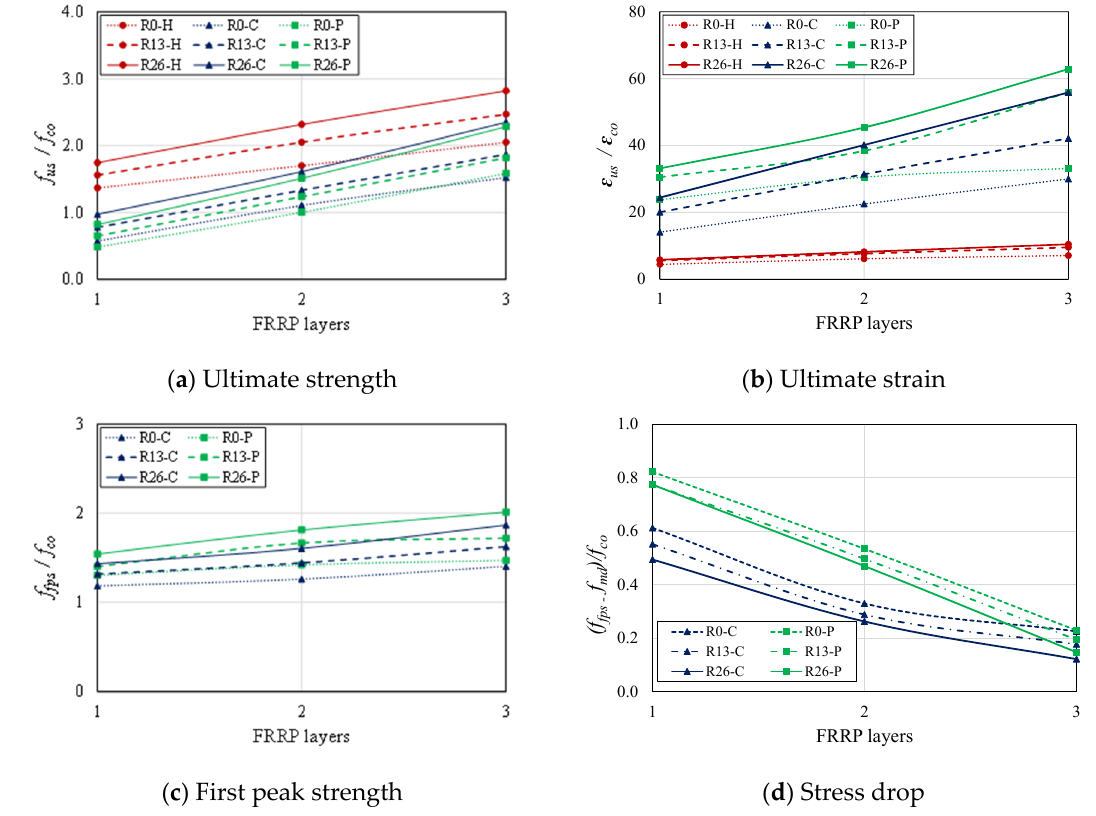
Figure 9. Effect of FRRP layers (R0 = 0 mm corner radius, R13 = 13 mm corner radius, R26 = 26 mm corner radius, H = hemp FRRP, C = cotton FRRP, P = polyester FRRP).